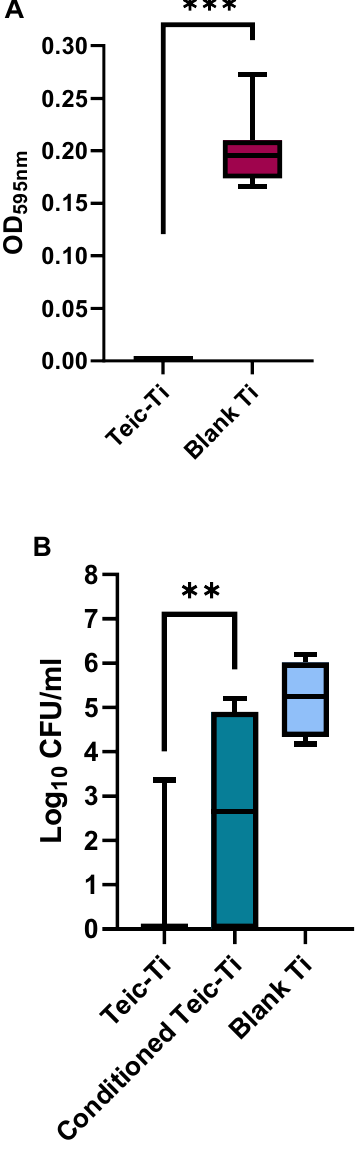
Figure 8. Antibacterial activity of Teic-Ti after culture conditioning. ( A ). Ti discs were exposed to Teic (500 µg/ ml in 50 mM MES, pH 5.4) and incubated for 2 h under ambient conditions. After incubation, discs were washed with distilled water to dislodge any loosely bound Teic and allowed to dry in a sterile environment. Control and functionalised Ti discs were then immersed in 1% Peptone/PBS and left for 24 h at 37 °C with gentle shaking (120 RPM). After incubation, the recovered conditioned media (100 µl) was transferred to a sterile 96-well plate and inoculated with S. aureus (100 µl) and left to incubate at 37 °C for 24 h. At the desired time the OD at 595 nm was measured to ascertain bacterial growth using a microplate reader. The significant reduction (*** p < 0.0001) in OD supports antibiotic leaching into the culture medium ( B ). To determine if the conditioned discs still retained any antimicrobial activity the control and functionalised Ti discs were transferred to a new multiwell plate and washed in distilled water twice, allowed to dry and then exposed to a 10 5 CFU/mL suspension of S. aureus and incubated for a further 24 h at 37 °C with gentle shaking (120 RPM). After incubation, discs were recovered, washed twice with 0.85% saline, and sonicated for 5 min in 1 ml of MRD to recover the attached bacteria. The detached bacteria were transferred to a new universal and incubated for 30 min at 37 °C in order to achieve maximum recovery. All data (mean ± SD; N = 9) represent pooled triplicate runs from 3 independent